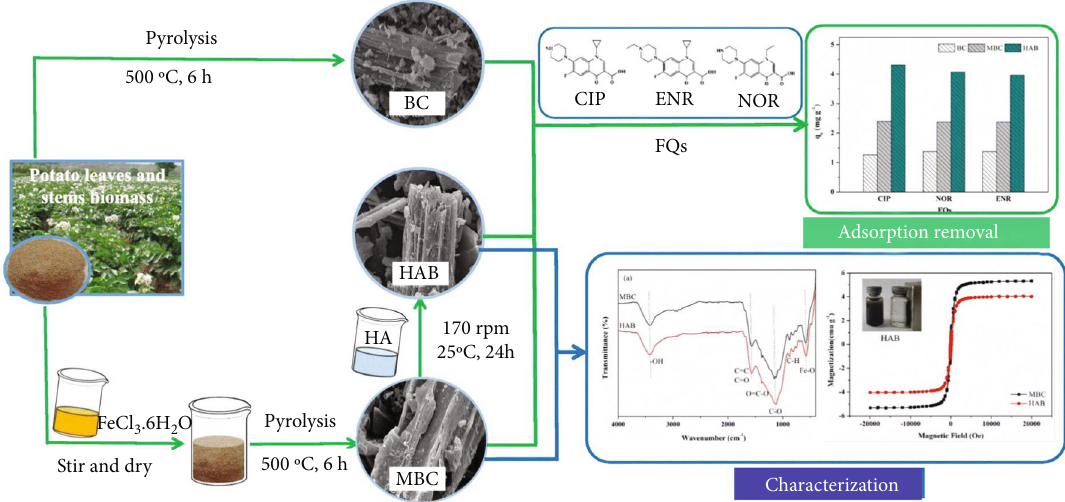
Figure 8: Humic acid coated magnetic biochar (MBC) derived from potato leaves and stems for fl uoroquinolone antibiotics removal from water